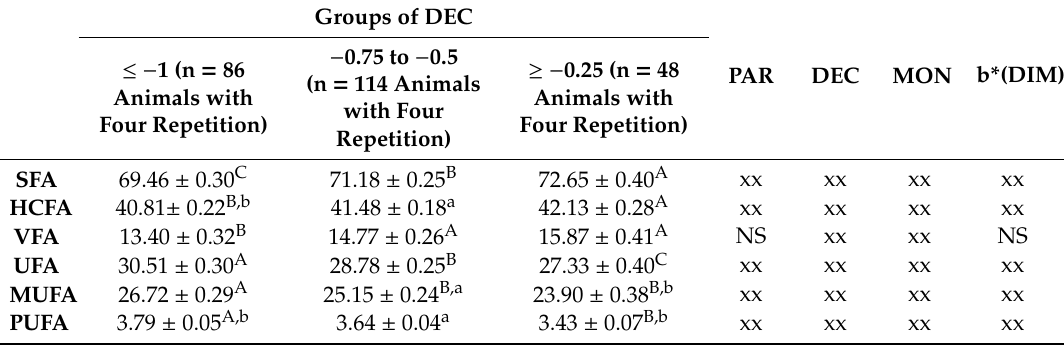
Table 1. E ff ects of body condition decline (DEC) groups on fatty acids group concentrations (LSM ± SELSM) and significance of e ff ects in model equation.